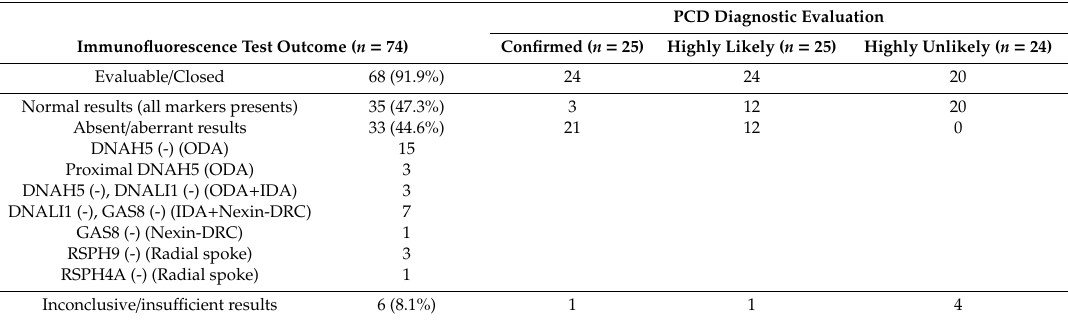
Table 1. Immunofluorescence results from 74 primary ciliary dyskinesia (PCD) suspected patients related to the results of the PCD diagnostic